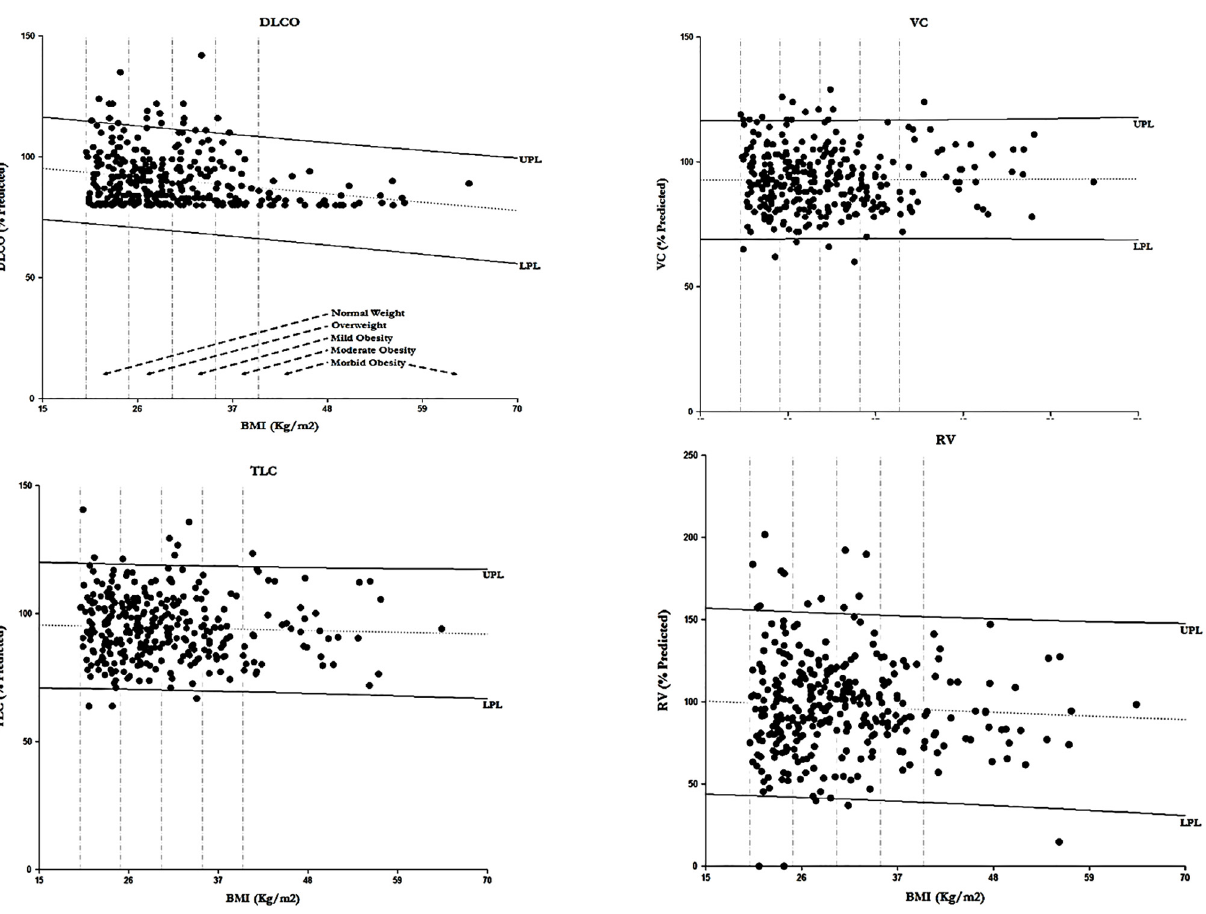
Fig 1. The linear regression between BMI and DlCO (top left), VC (top right), TLC (bottom left), and RV (bottom right). Linear regression between BMI and DLCO (P < .0001), VC (P = 0.895), TLC (P = 0.459) and RV (P = 0.301). The intervals represent the lower prediction limit (LPL) and the upper prediction limit (UPL) of the regression line. The vertical dash lines are the cut-points separating the BMI categories defined in the DLCO graph. The slopes of the linear regression for percentage of predicted values and BMI were -0.166 (DLCO), 0.005 (VC), -0.026 (TLC), and -0.016 (RV).